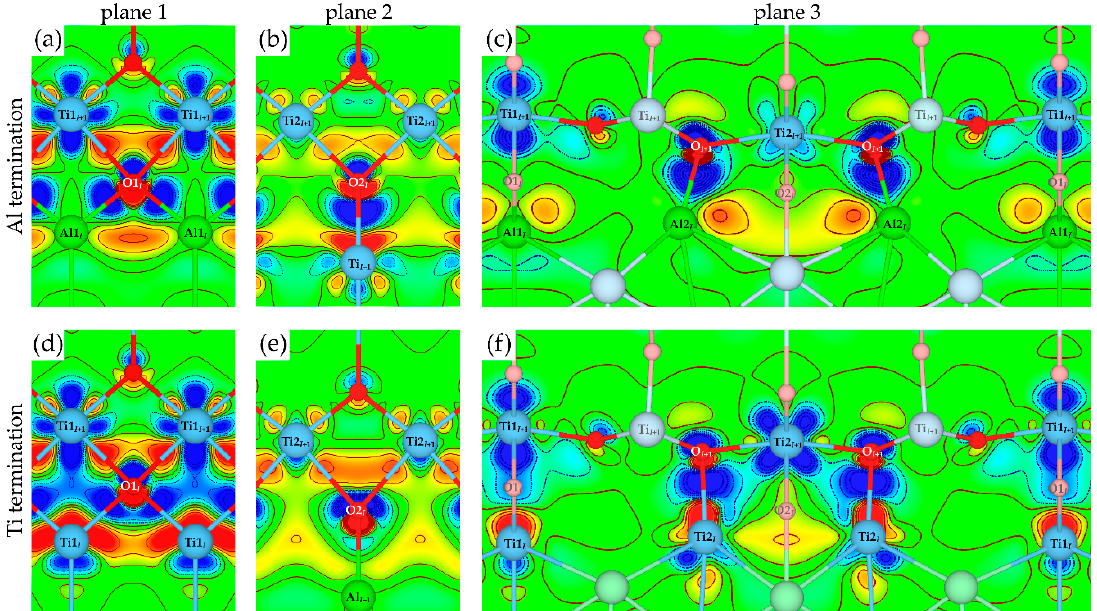
Figure 4. Distribution of the charge density difference ( Δ ρ ) at the TiAl/TiO 2 interface in the case of the hollow configuration in planes shown in Figure 3c: ( a – c ) Al termination; ( d – f ) Ti termination. The regions of electron accumulation ( Δ ρ < 0) and depletion ( Δ ρ > 0) are given in blue and red, respectively. Contours go –0.1 to 0.1 el./Å 3 with an isoline spacing of 0.02 el./Å 3 . Atoms being out of the figure plane are shown in lighter colors. Table 3. Charge states of some interfacial and subinterfacial atoms ( Q in el.), bond length between them ( d in Å) and averaged overlap population ( θ in el.) for pairs of the atoms in the case of the hollow interface configuration. The corresponding data for free surfaces of the alloy and the oxide are given also.